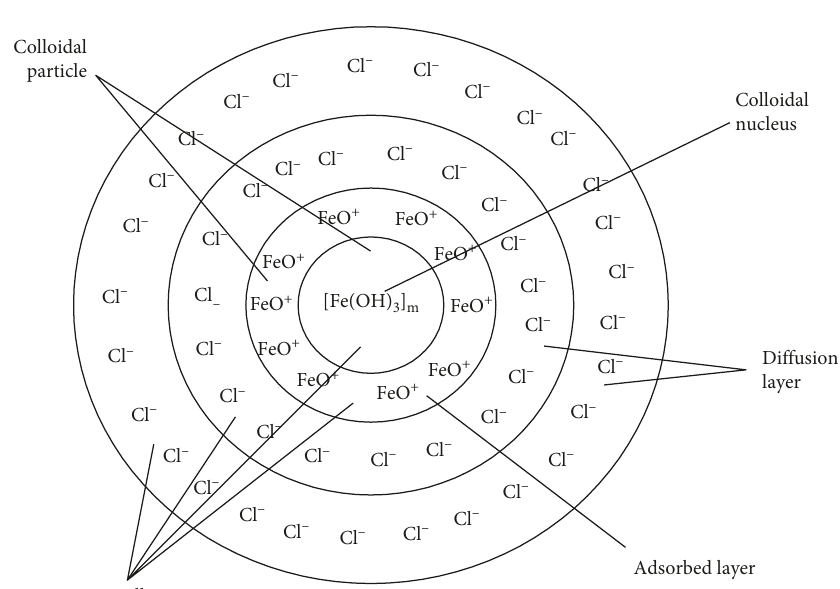
Figure 7: Diagram of Fe(OH)